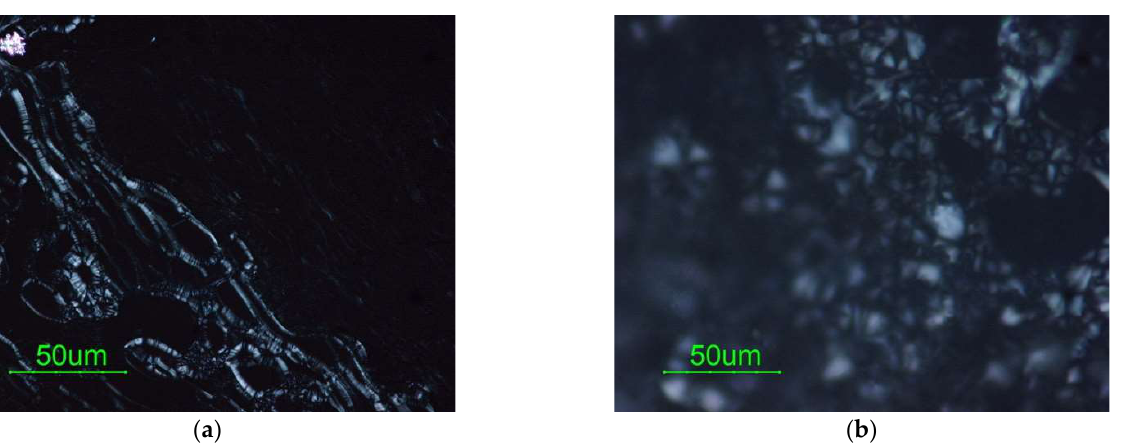
Figure 7. ( a ) oily streaks and ( b ) mosaic texture for the dispersed system in the S/O 25/75 dilution line with 20% of water content. line with 20% of water